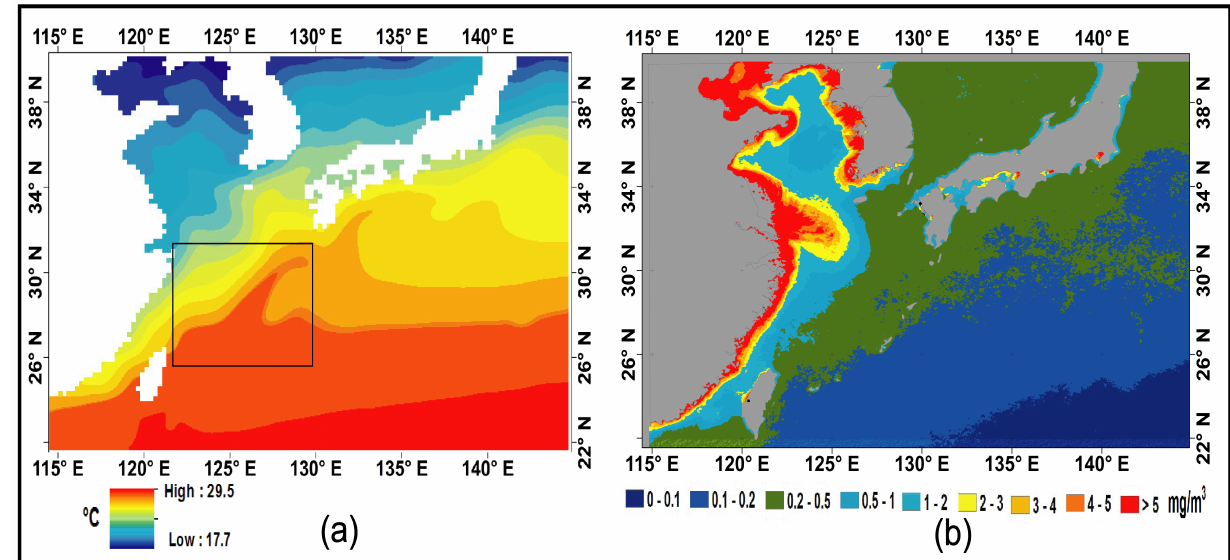
Figure 5. Climatological annual mean distributions recreated for our study area ( a ) SST from OISST version 2.0 between 2000–2009 illustrating isolines and Kuroshio warm tongue inside the black box; ( b ) Oceancolour Version 4.2 chlorophyll- α average from 1998–2010 to demarcate KC as per the methodology by Liu and Hou